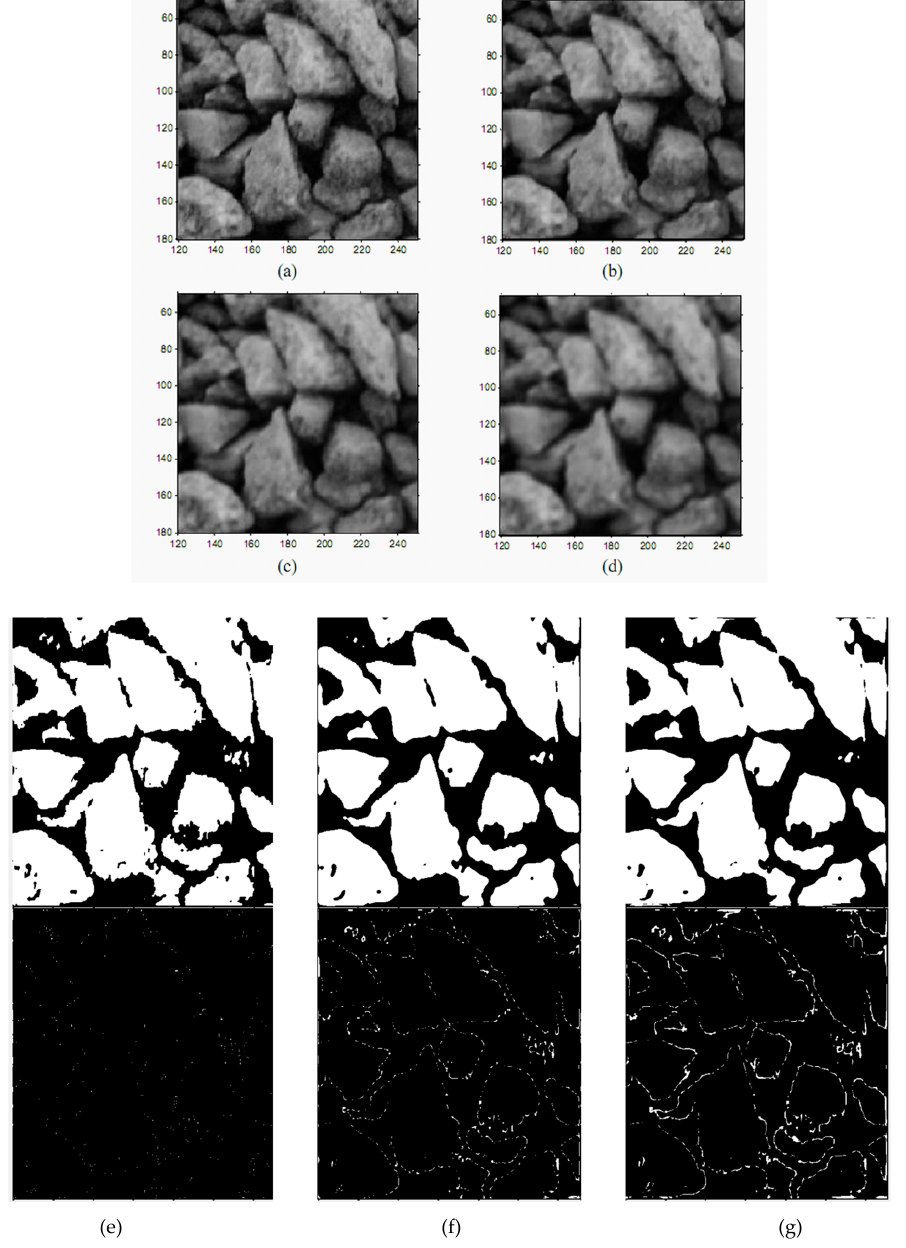
Figure 2. ( a ) Original image; ( b ) application of 3 × 3 median filter; ( c ) application of 9 × 9 Gaussian filter with σ = 1; ( d ) application of 9 × 9 average filter; ( e – g ) binarized images (using Otssu algorithm) and contour by subtraction of original image.